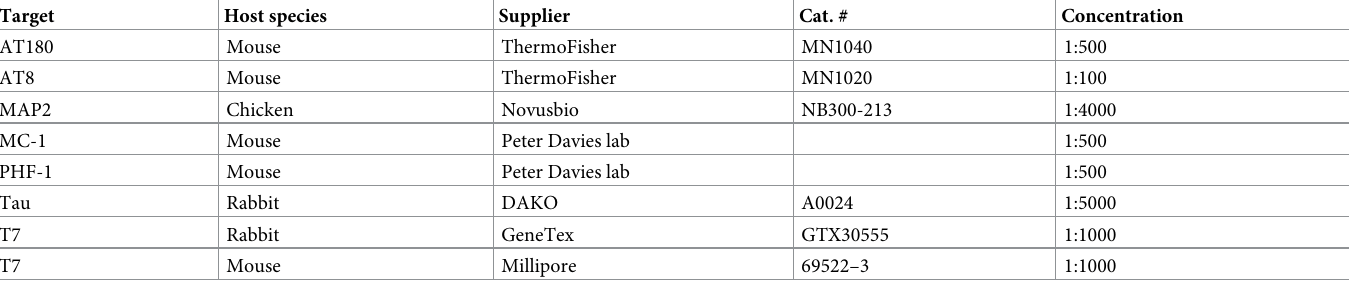
Table 1. Primary